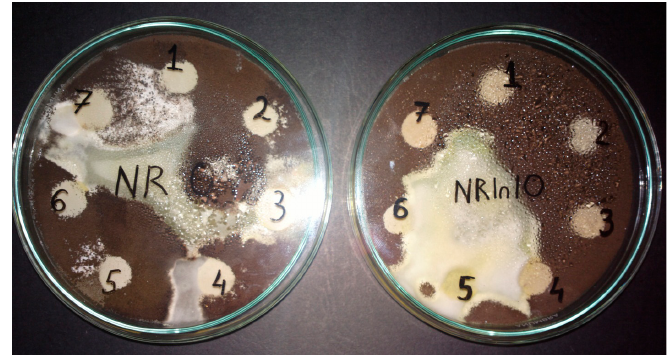
Figure 2. Appearance of NF (free natural fibers) and NR with 10 phr flax samples after 15 days.